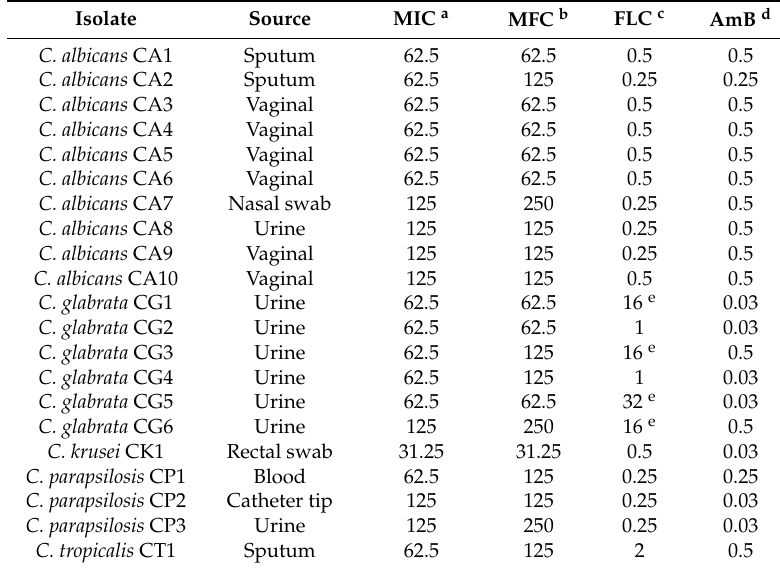
Table 2. Anti- Candida activity of the complex 1 [CuCl 2 (Bipy)(L 1 )] in planktonic cells by microdilution in broth technique ( µ g/mL).